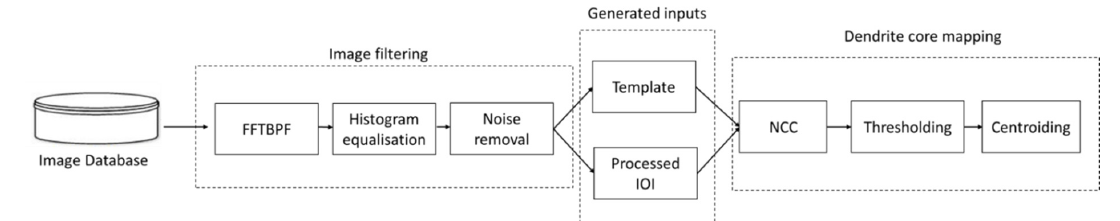
Figure 8. Flow chart for the image processing and detection route of DenMap.